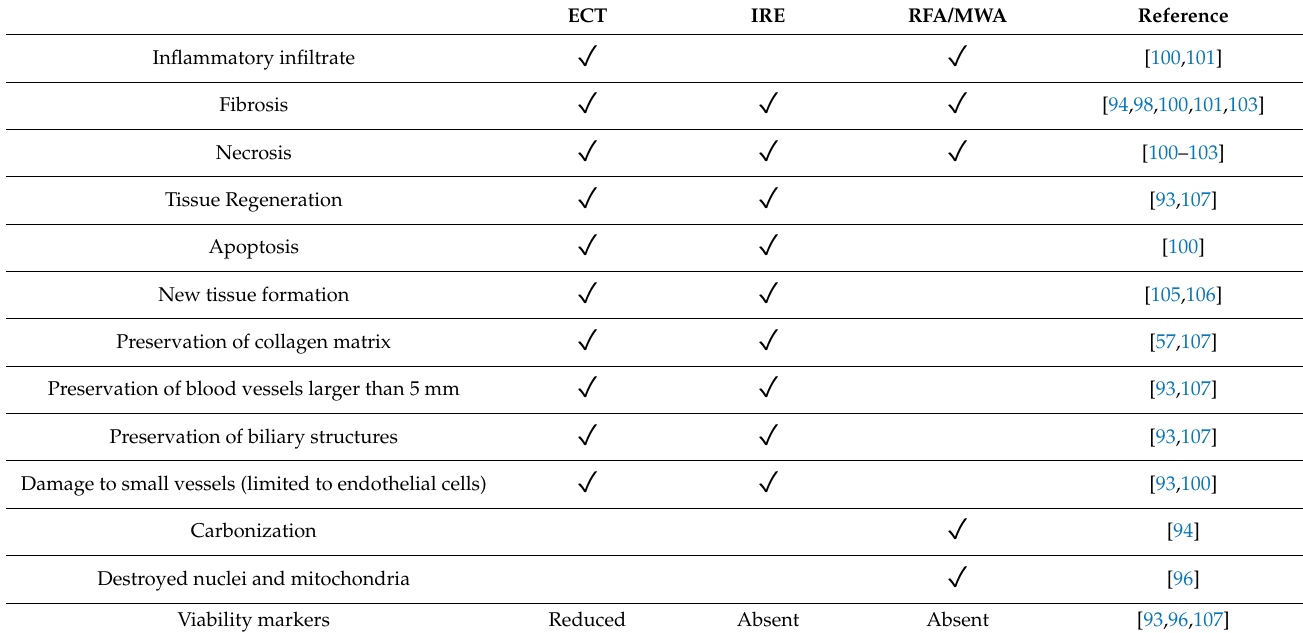
Table 3. Histopathological findings of ECT, IRE and RFA.